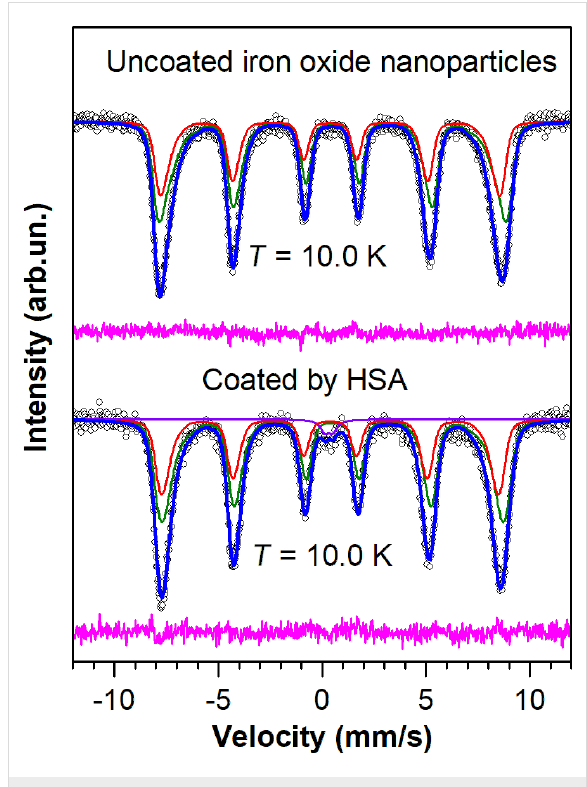
Figure 6: Mössbauer spectra of uncoated and HSA-coated magnetic nanoparticles at 10 K. Red and green sextets correspond to iron ions in A- and B-sites of the spinel crystal structure.